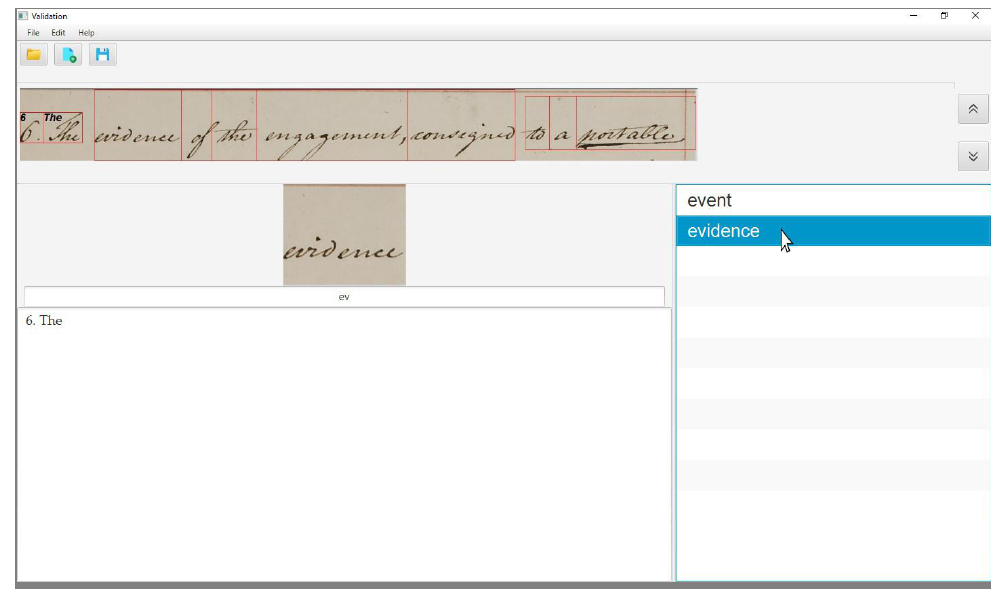
Figure 4. The user interface after a few characters of the word to transcribe have been entered. The output list is updated and, once the correct transcription appears in the box, the user validates the correct transcription by just a click.